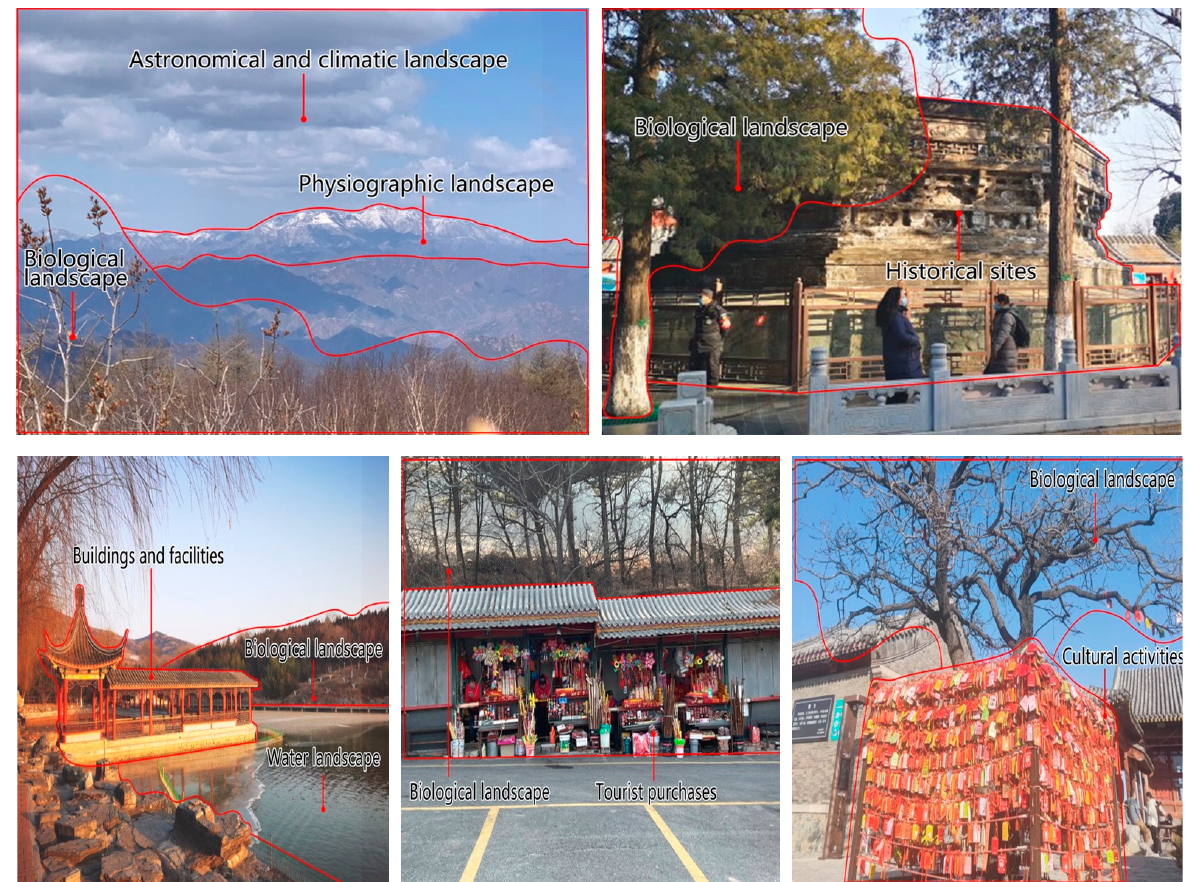
Figure 2. Images of the classification of mountain landscape resources. Table 2. Classification of landscape resources.